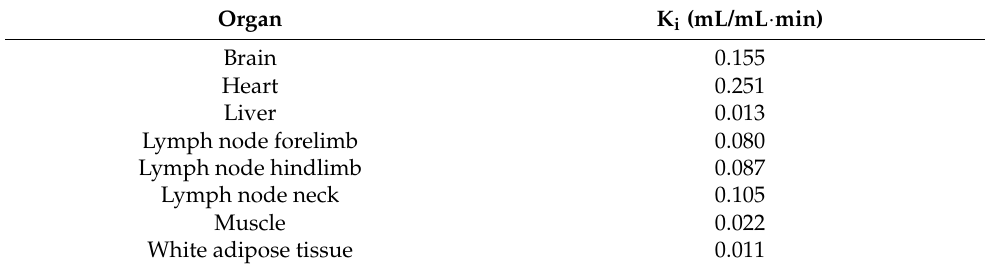
Table 1. Representative plasma glucose-corrected net influx rate (Ki) of 18 F-FDG uptake obtained by dynamic PET and Patlak analysis (please see the method section for detailes) from one of the raccoon